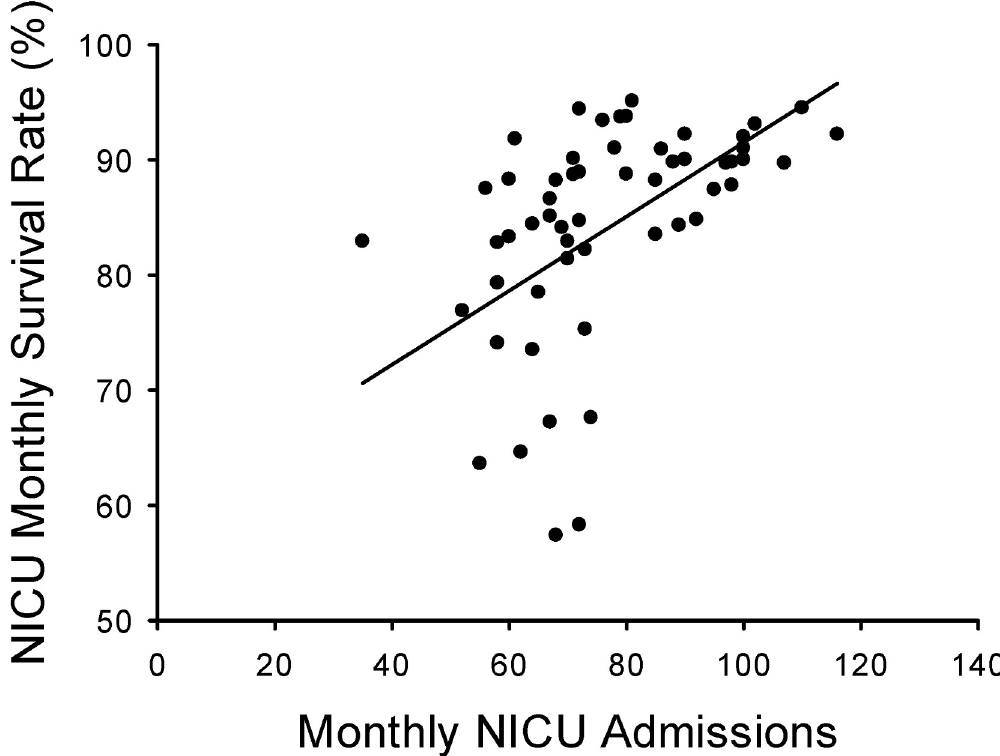
Fig 5. The monthly NICU survival rate was positively correlated with the number of admissions. There was a positive correlation by linear regression analysis between monthly NICU admissions and monthly NICU survival (survival % = (0.32 x number of admits) + 59.4; R = 0.55; R 2 = 0.30; p <